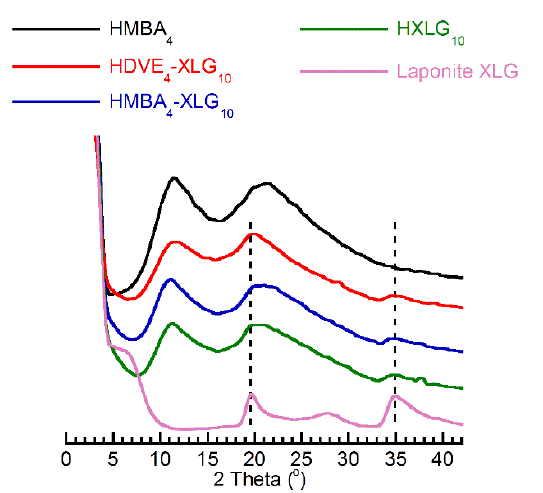
Figure 6. XRD diffractograms of NC hydrogels in comparison with Laponite XLG and the PNVP matrix.